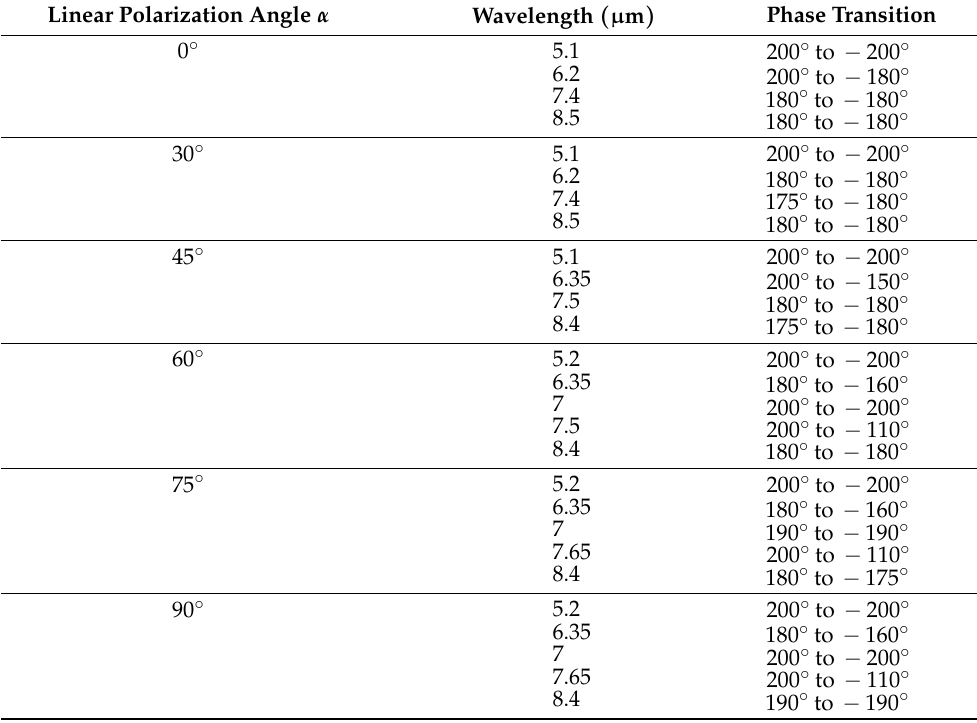
Table 5. Phase transitions associated with the reflected wave across the phase spectrum in the case of structure 1C, at linear polarization states defined by α = 0 ◦ , α = 30 ◦ , α = 45 ◦ , α = 60 ◦ , α = 75 ◦ and α = 90 ◦ .